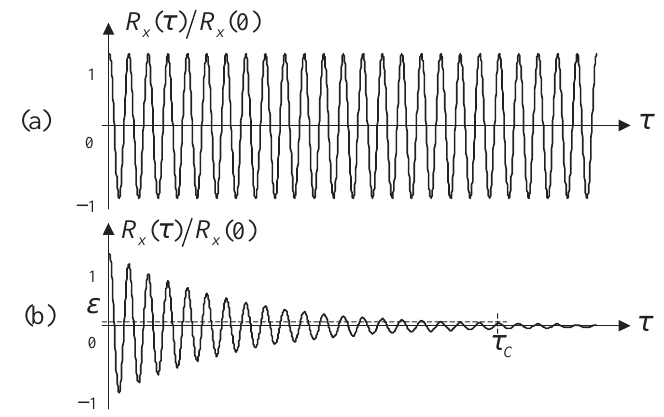
Fig. 8. The correlation time indicator is based on the property that the autocorrelation function of a pure tone has an infinite duration (a), whereas that of a random noise is transient (b).